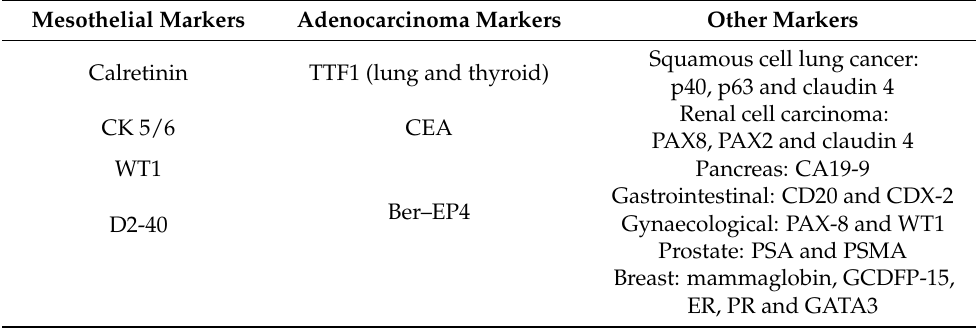
Table 1. Immunohistochemical markers for differentiating tumour types in malignant pleural effusion [12,24]. Adapted from Bibby et al.